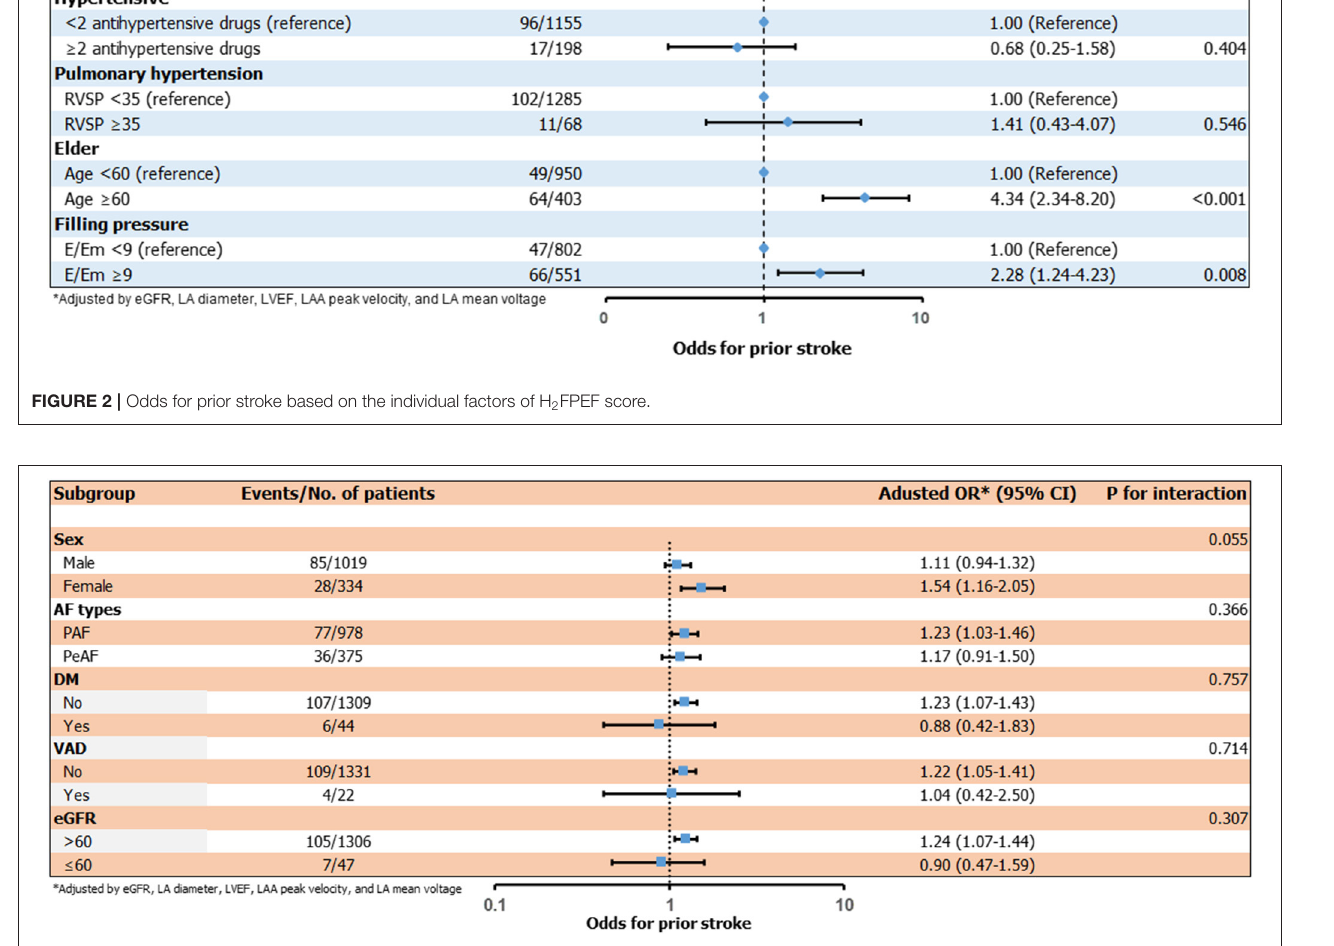
FIGURE 3 | Subgroup analysis of the risk of prior stroke by an increase in the H 2 FPEF